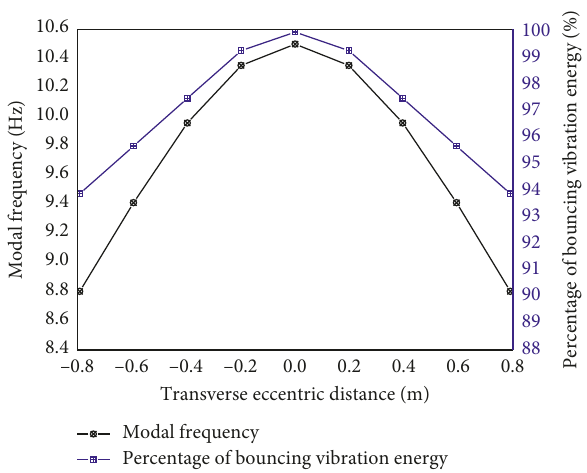
Figure 10: Influence of the transverse eccentricity on the modal frequency and energy